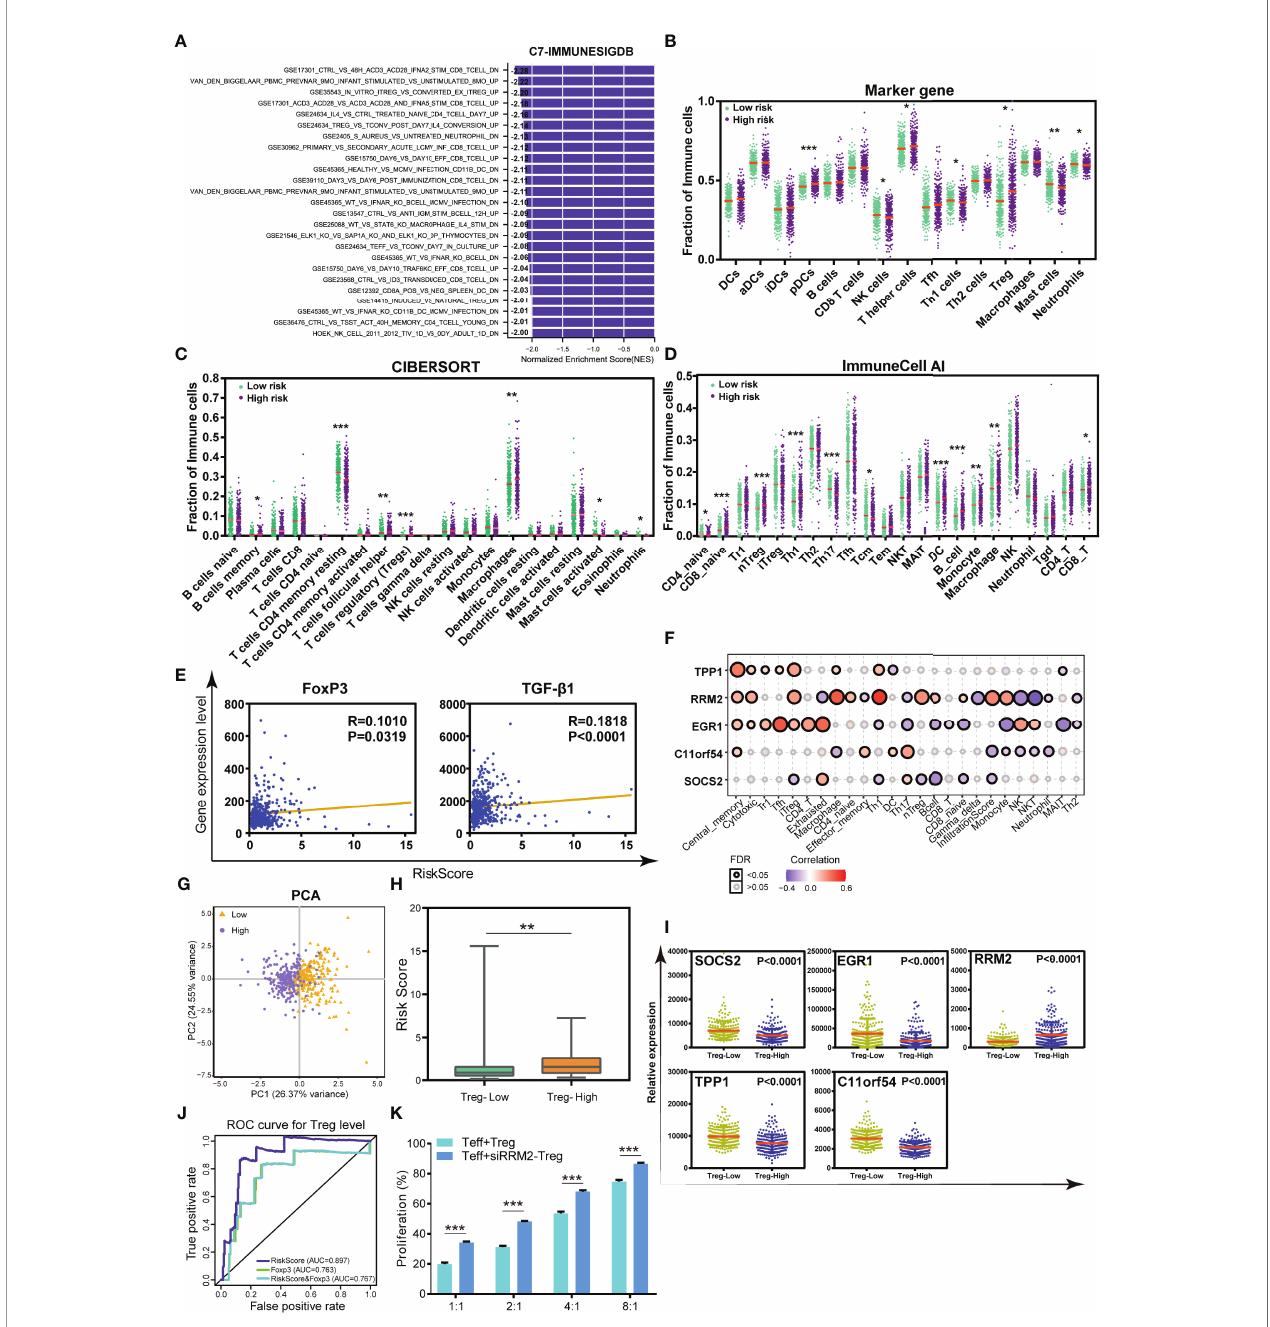
FIGURE 6 | The TILTregSig can serve as a predictor for Tregs in prostate cancer. (A) GSEA of the TILTregSig using the gene set of “ c7.all.v7.4.symbles.gmt [immunologic signature] ” . The in fi ltration of immune cells in high- and low-risk groups strati fi ed by the risk score in prostate cancer samples from the TCGA dataset using marker genes ’ expression analysis (B) , CIBERSORT algorithm (C) , and ImmuneCell AI database (D) . (E) The correlation of the TILTregSig with FoxP3 and TGF- b 1 expression. (F) The correlation of the fi ve genes in the TILTregSig with tumor-in fi ltrating immune cells in prostate cancer samples from TCGA. (G) Principal components analysis (PCA) of the risk scores between Treg-low and Treg-high samples in prostate cancer. The distribution of the risk scores (H) and the expression of fi ve genes (I) among samples grouped by the in fi ltration of Tregs in prostate cancer. (J) Comparison of predictive ability of the TILTregSig and FoxP3 for Treg in fi ltration using ROC curve analysis. (K) The proliferation rates of Teff cells (Teff:Treg = 1:1, 2:1, 4:1, and 8:1) with normal Tregs or si-RRPM Tregs. *, P<0.05. **, P<0.01. ***,